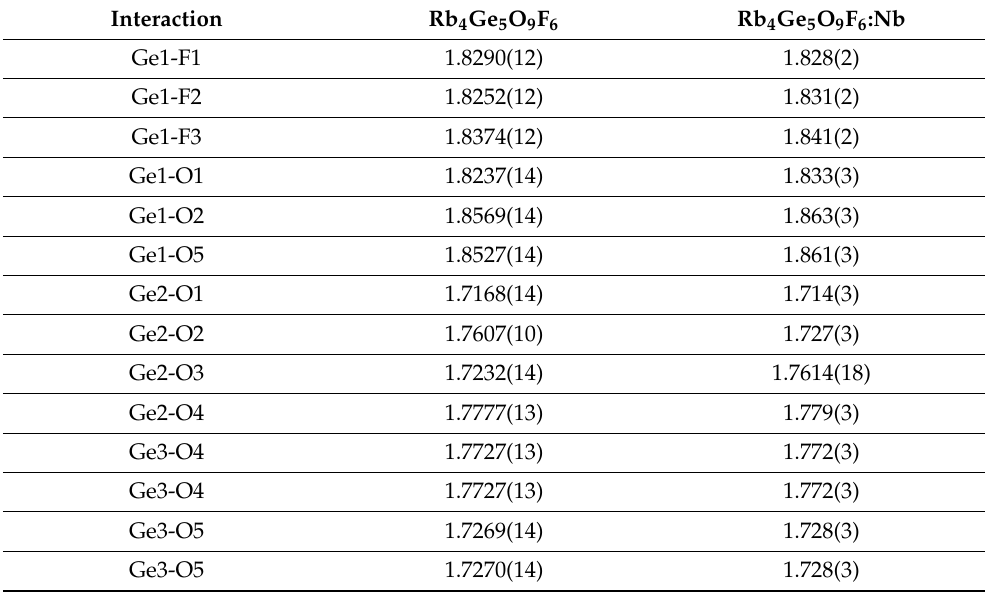
Table 2. Selected interatomic distances (Å) for Rb 4 Ge 5 O 9 F 6 and Rb 4 Ge 5 O 9 F 6